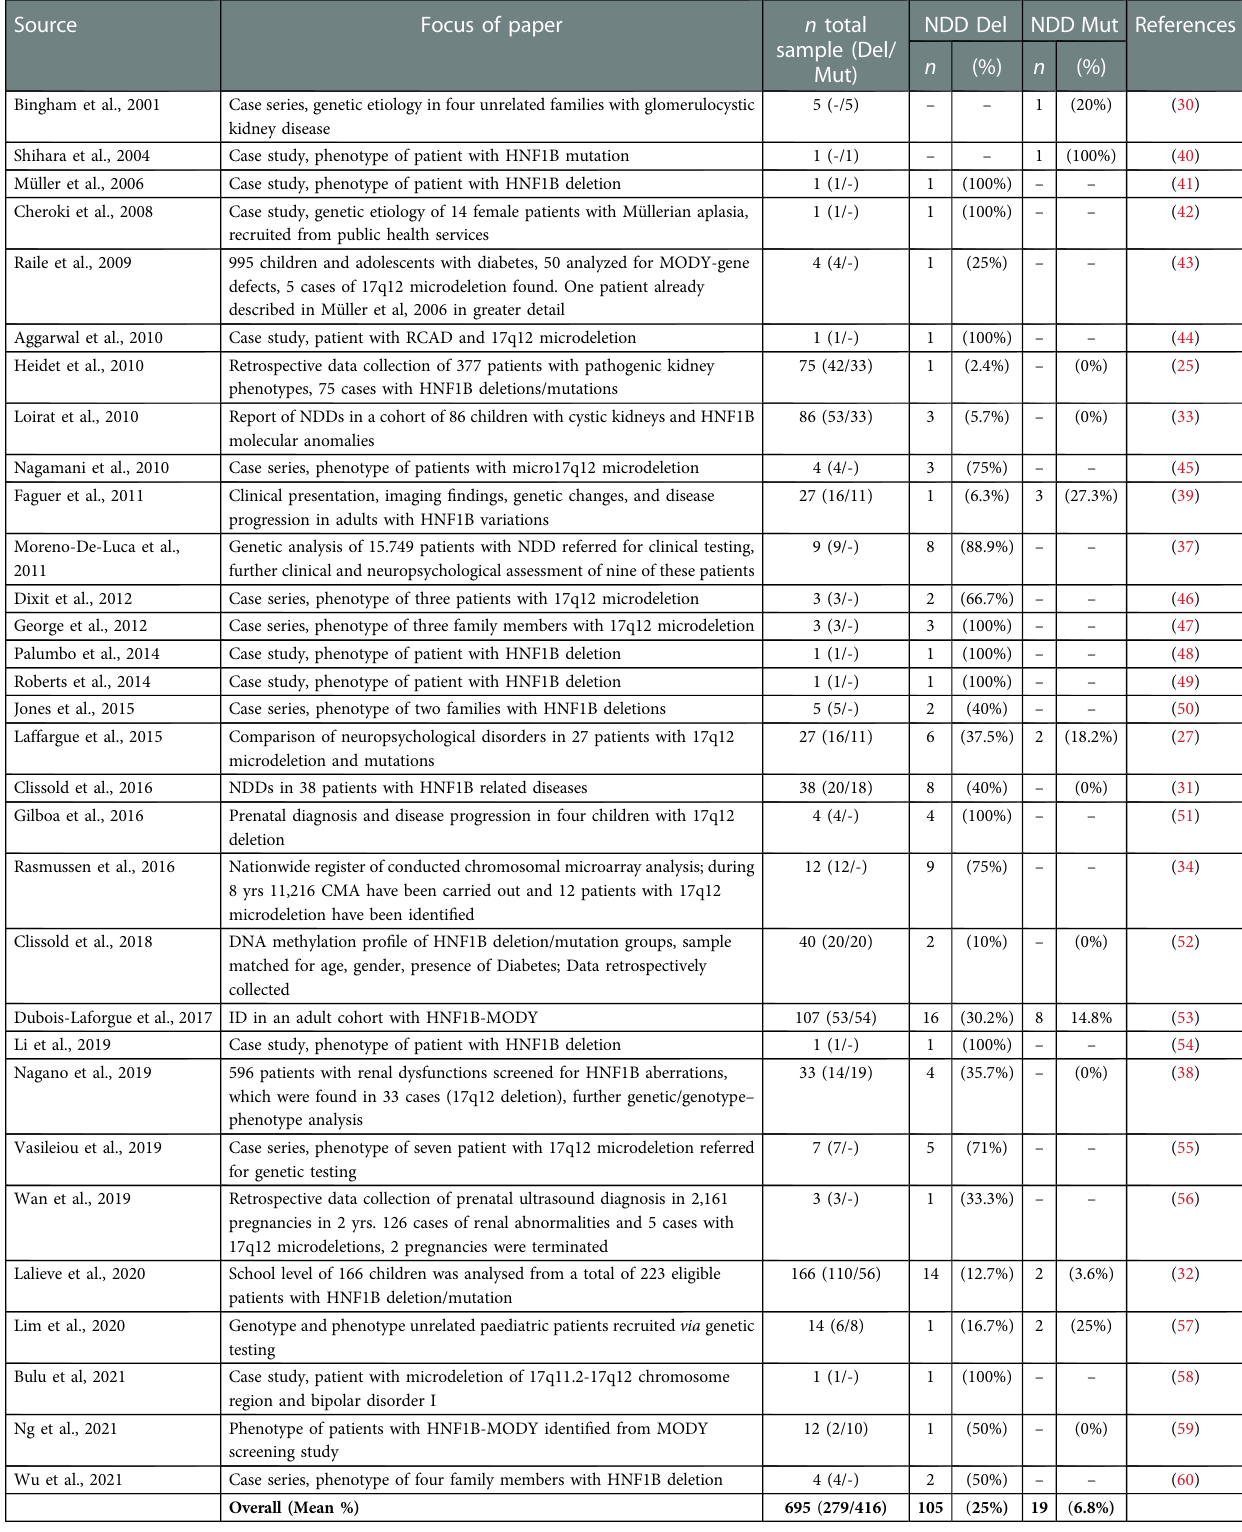
TABLE 1 Percentages of neurodevelopmental disorders (NDD) in studies reporting on NDDs in patients with 17q12 microdeletions and HNF1B mutations.